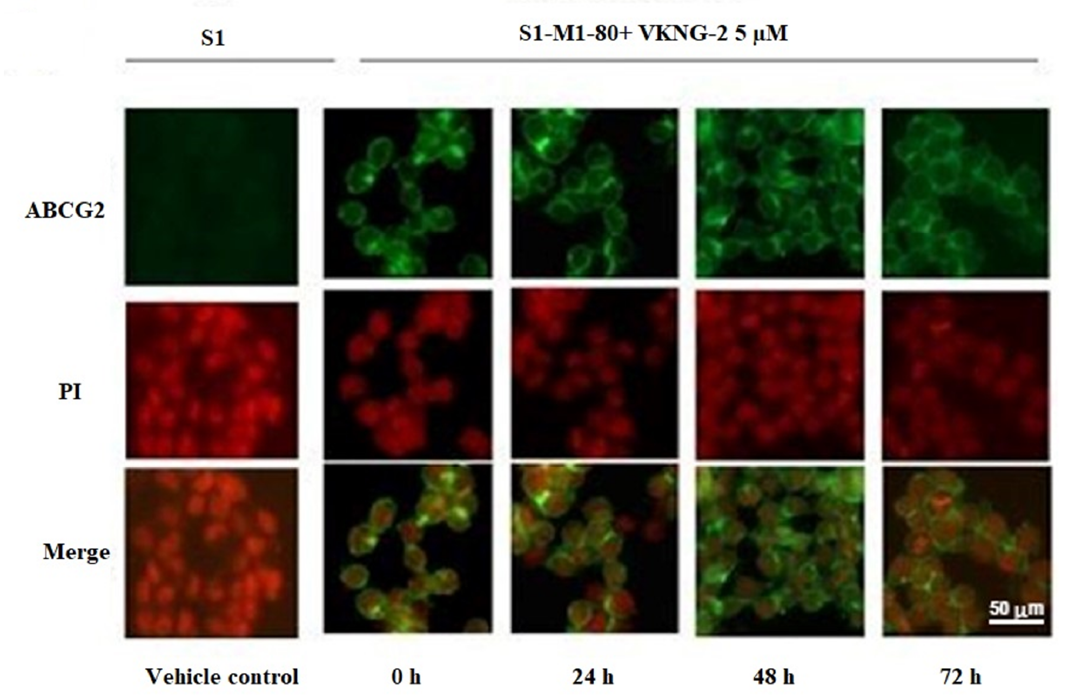
Figure 7. The effect of VKNG-2 on the expression and localization of ABCG2 using immunofluorescence. The effect of the incubation of S1 and S1-M1-80 colon cancer cells with vehicle (Control) or 5 µ M of VKNG-2 for incubated for 0, 24, 48 or 72 h. The green color represents the presence of the ABCG2 transporter, and the red color represents the